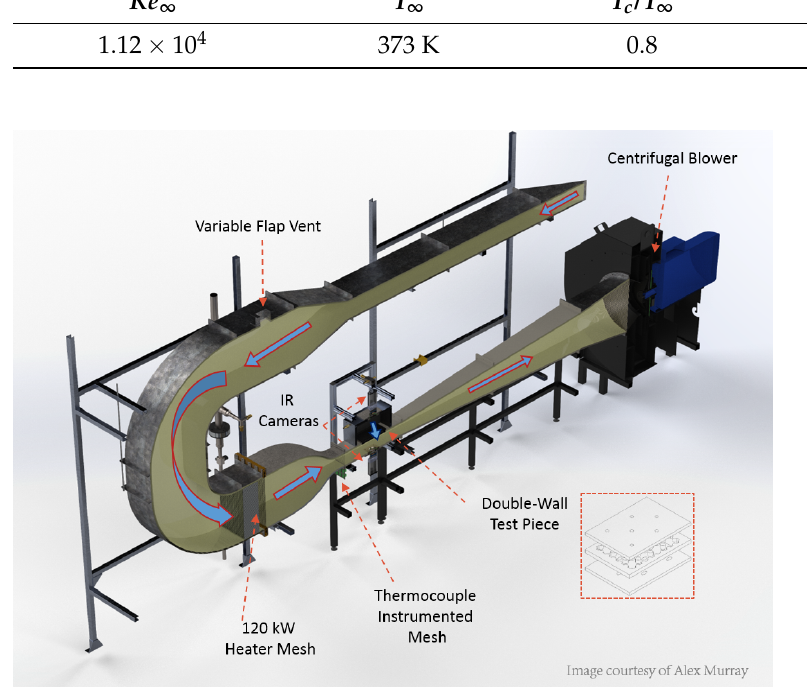
Figure 3. Annotated schematic of the OTI experimental